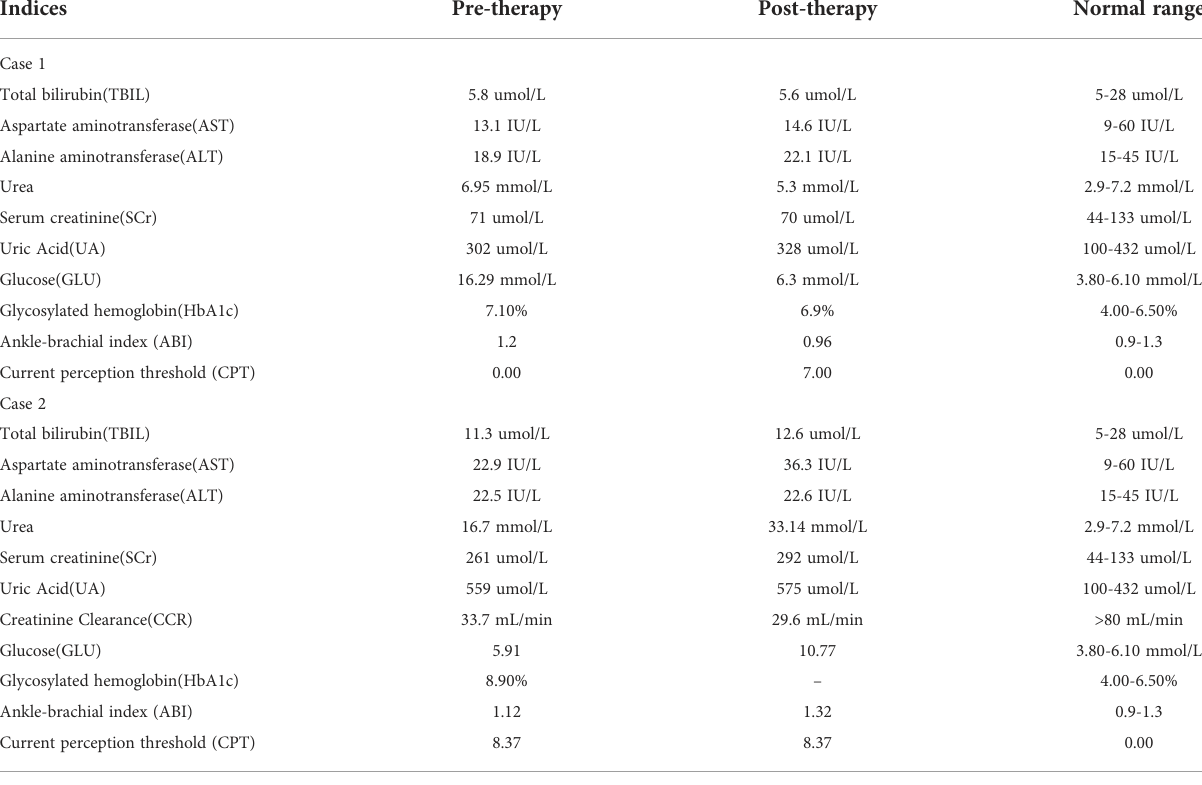
TABLE 1 Details of blood routine, blood glucose level and other